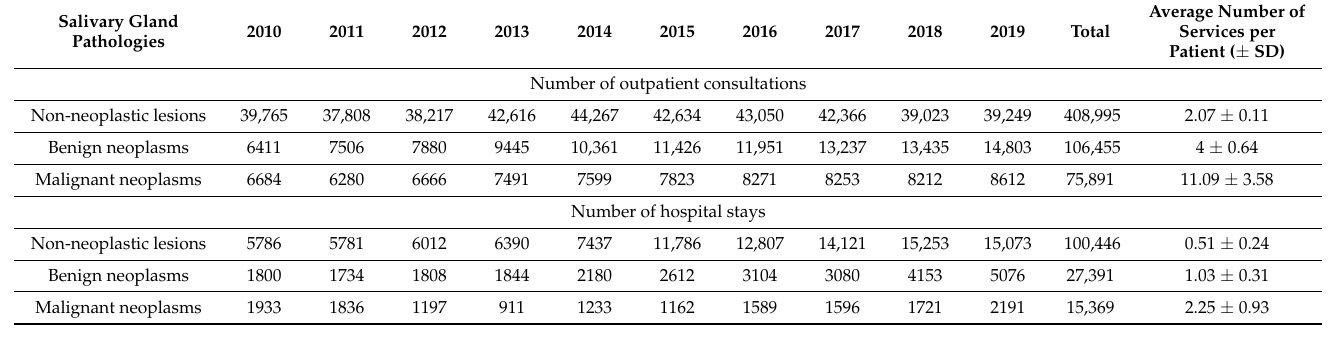
Table 3. Number of inpatient and outpatient services among patients with non-neoplastic, benign, and malignant salivary gland lesions in 2010–2019 in Poland (SD—standard deviation).